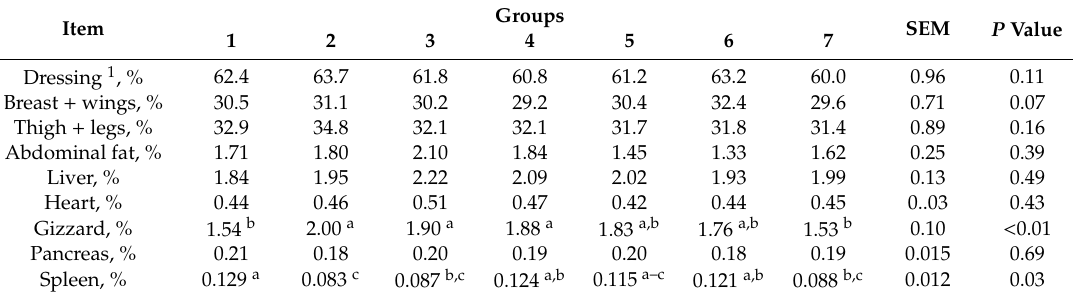
Table 5. Carcass yield of broiler chickens (Trial